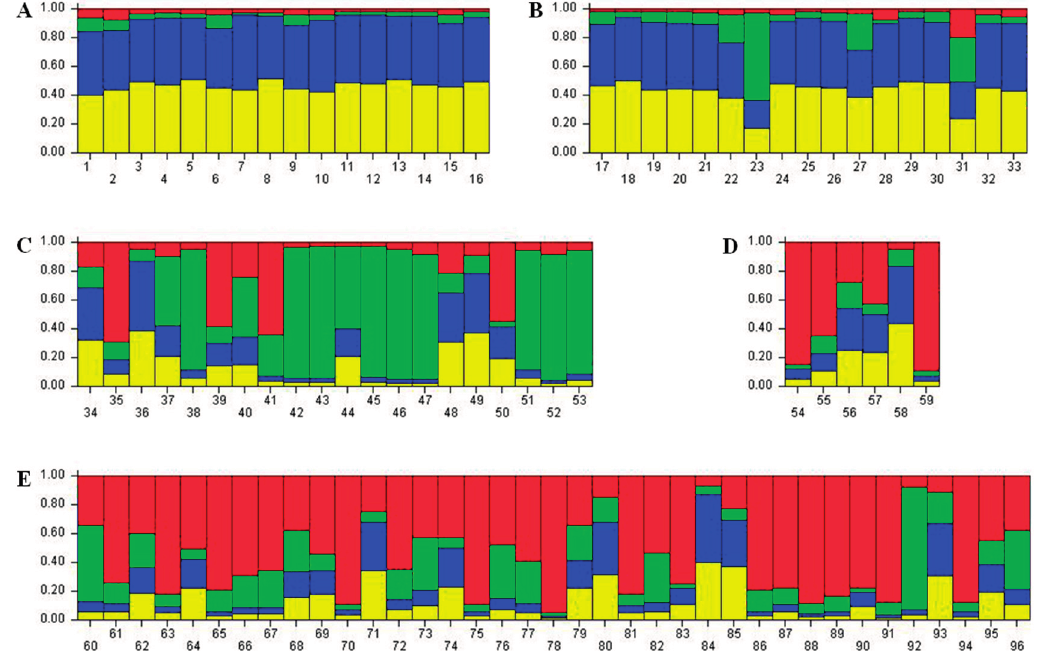
Figure 3. The bar plots in multiple lines were estimated by STRUCTURE. The best K was estimated as four based on the ad-hoc statistics ∆ ( K ) ( A , Shichuan China; B , Guangxi China; C , Wanju Korea; D , Nirasaki Japan; E , Nonsan Korea provided from insect